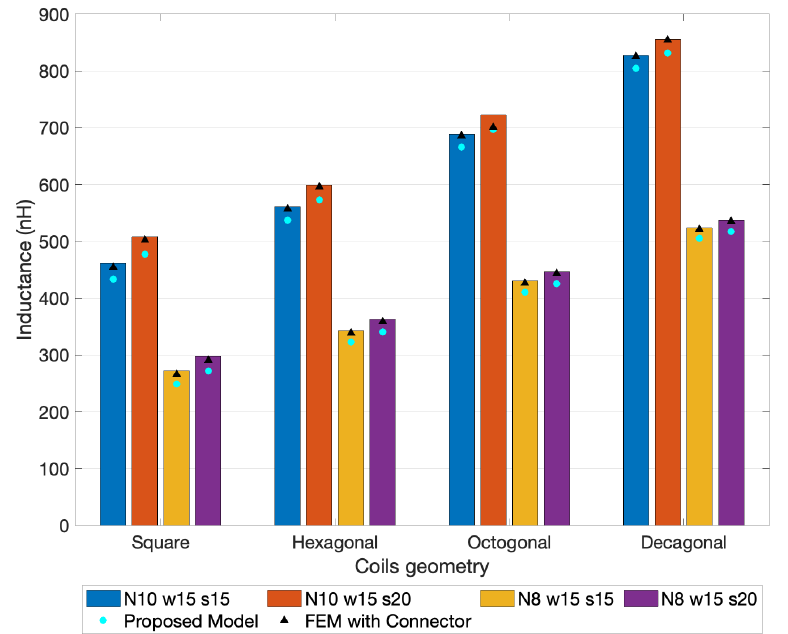
Figure 16. Graphic with the average inductance values from the experimental measurements and FEM simulation